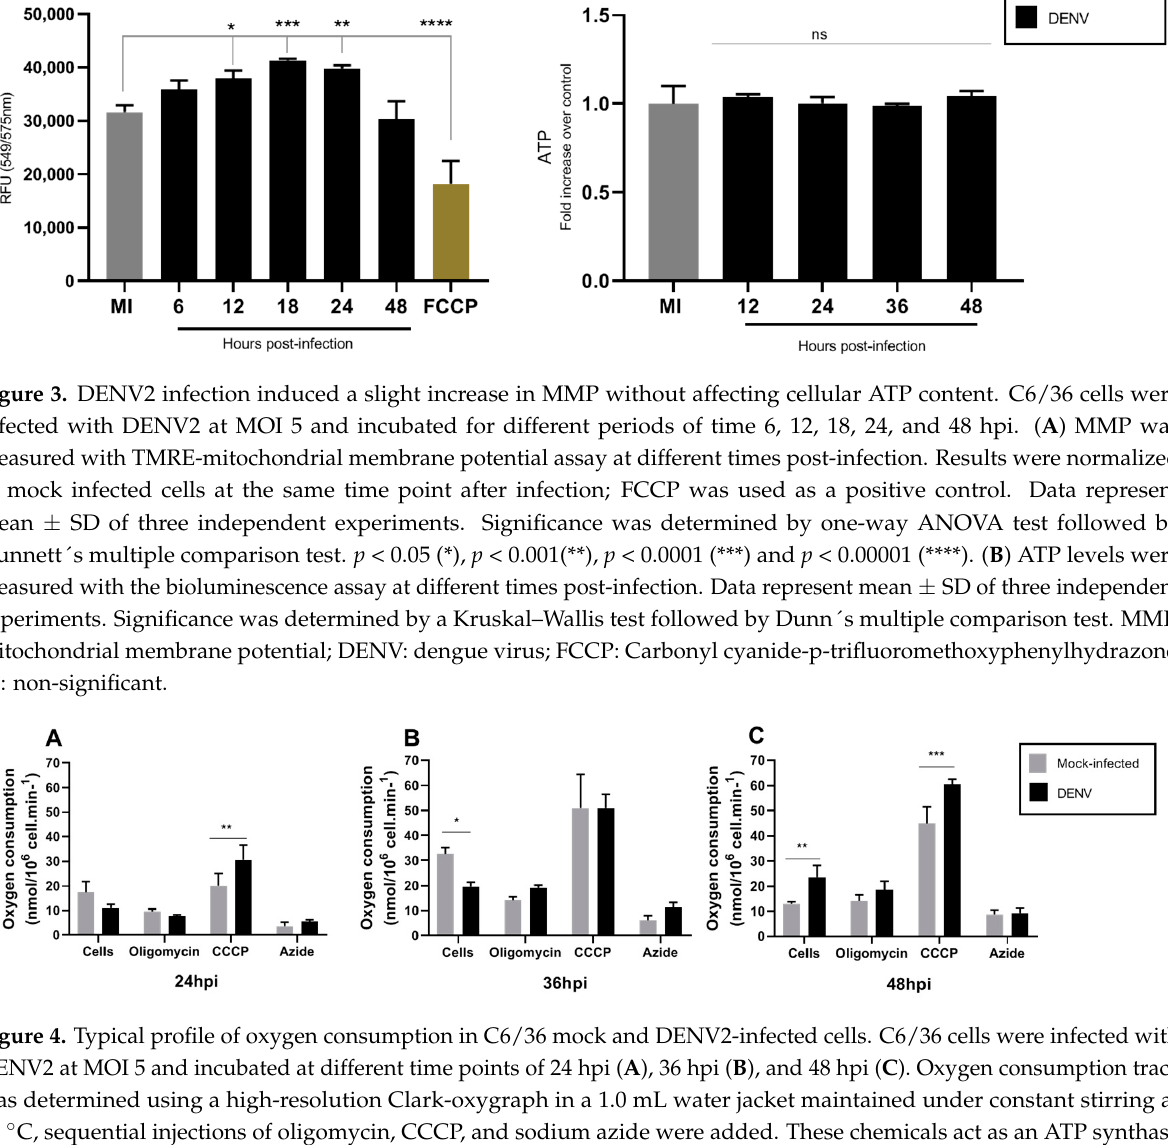
Figure 3. DENV2 infection induced a slight increase in MMP without affecting cellular ATP content. C6/36 cells were infected with DENV2 at MOI 5 and incubated for different periods of time 6, 12, 18, 24, and 48 hpi. ( A ) MMP was measured with TMRE-mitochondrial membrane potential assay at different times post-infection. Results were normalized to mock infected cells at the same time point after infection; FCCP was used as a positive control. Data represent mean ± SD of three independent experiments. Significance was determined by one-way ANOVA test followed by Dunnett´s multiple comparison test. p < 0.05 (*), p < 0.001(**), p < 0.0001 (***) and p < 0.00001 (****). ( B ) ATP levels were measured with the bioluminescence assay at different times post-infection. Data represent mean ± SD of three independent experiments. Sig- nificance was determined by a Kruskal–Wallis test followed by Dunn´s multiple comparison test. MMP: mitochondrial membrane potential; DENV: dengue virus; FCCP: Carbonyl cyanide-p-trifluoromethoxyphenylhydrazone; ns: non-signif- icant.